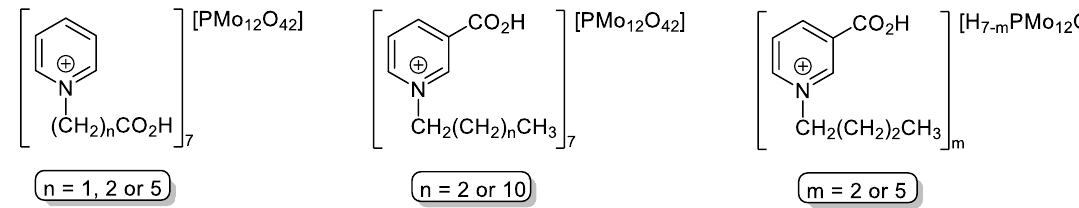
Figure 1. Different polyoxometalate-based ionic liquids derived from pyridine or pinacolinic acid, employed by Glotov and co-workers as catalysts for the oxidation of organosulfur compounds in both model and real diesel fuels [9].